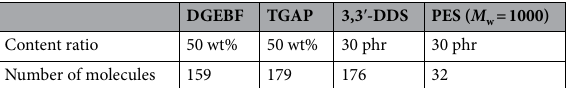
Table 1. Properties of the PES and epoxy system for